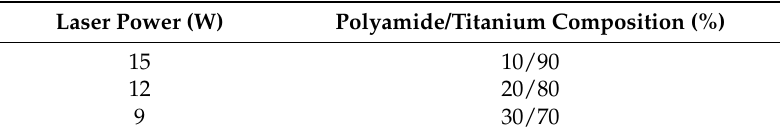
Table 1. Laser power required to sinter various configurations of polyamide